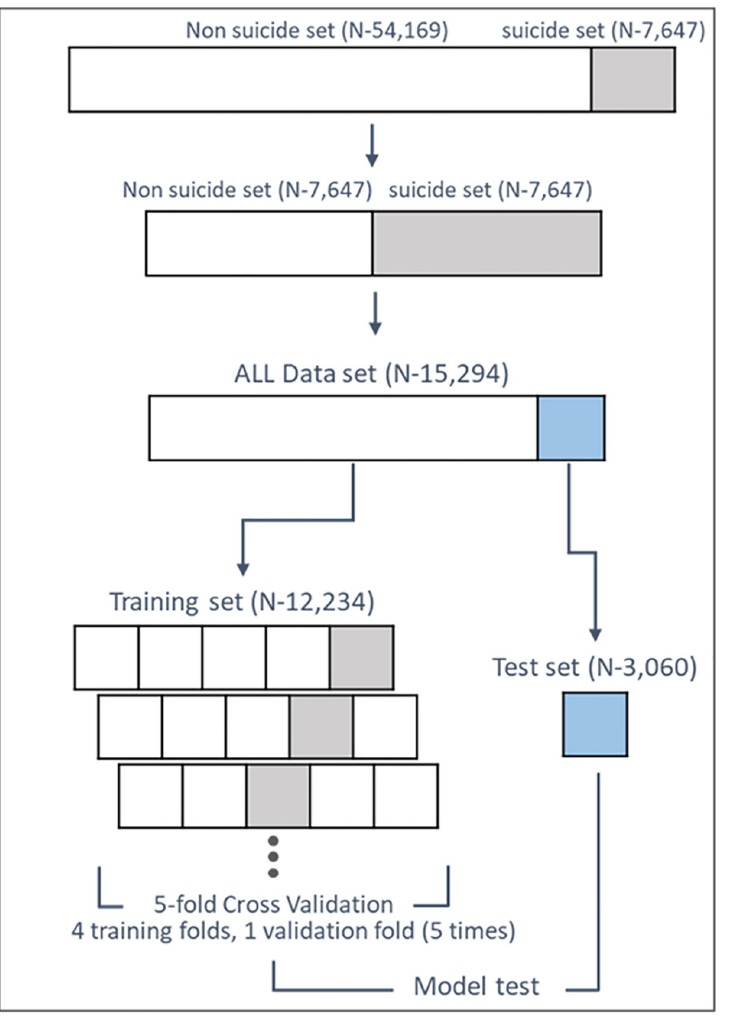
Fig 1. Scheme prediction model